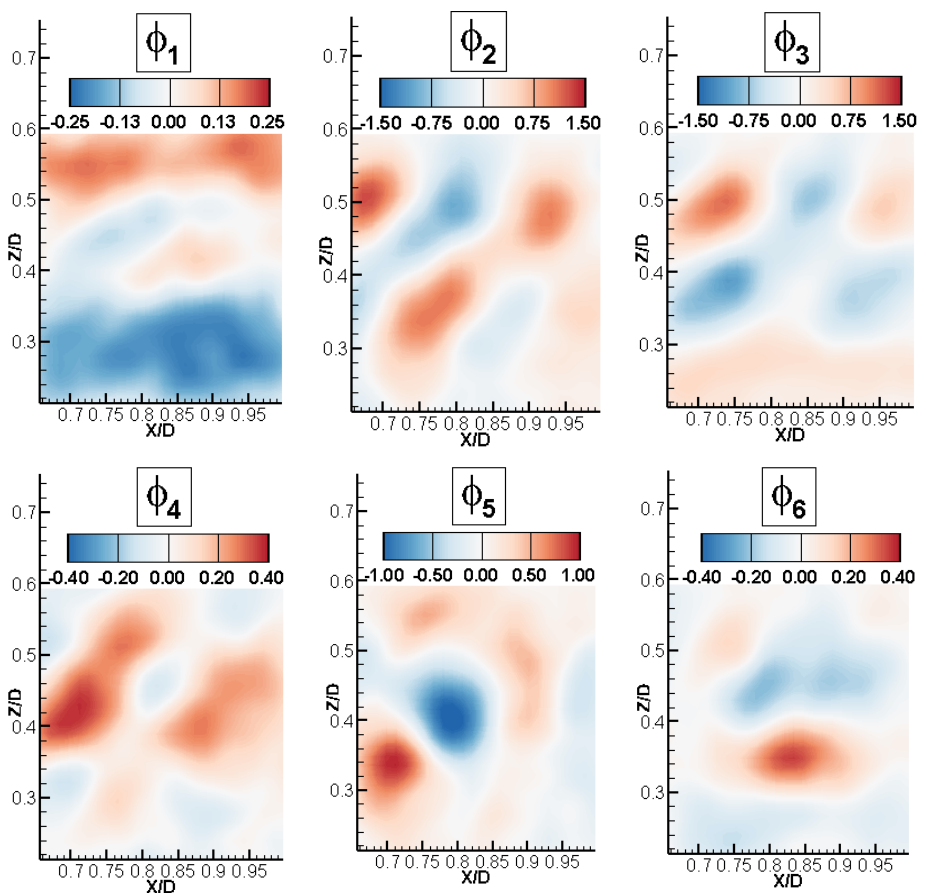
Figure 17. Normalized vorticity contours of vorticity-based POD mode shapes for R2 region.